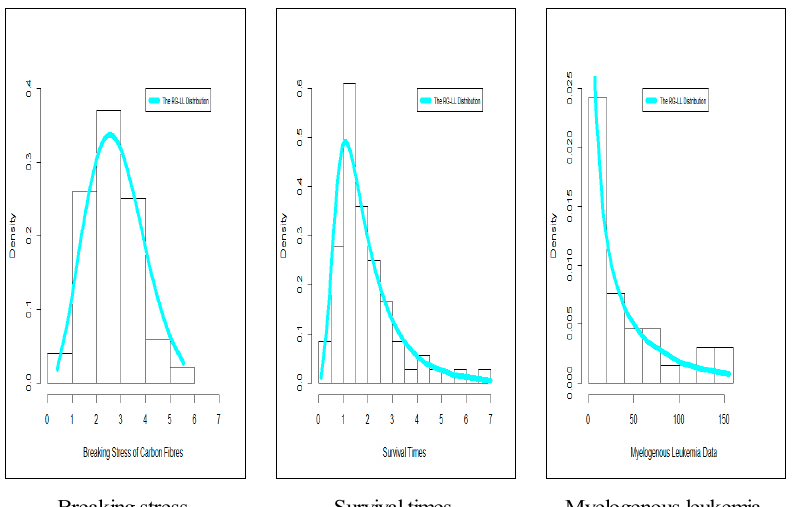
Figure 4. Estimated PDFs.